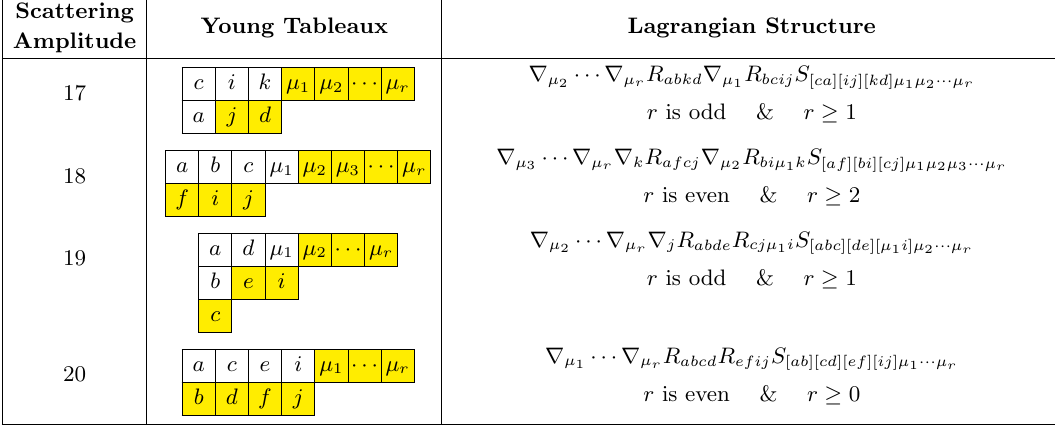
Table 6. Gravitons , D (cid:21) 8. The colouring principle of the Young’s Tableaux, in the second column of this table, has been outlined in the caption to table